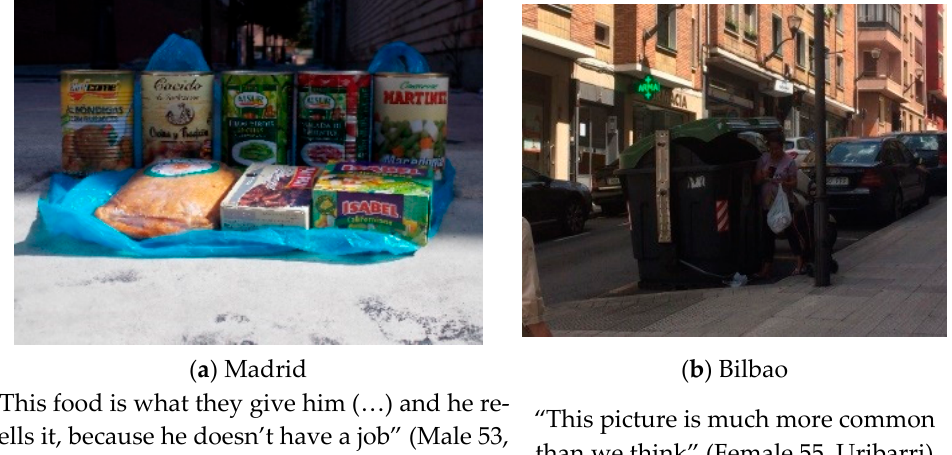
Figure 4. ( a ) Photographs made in Madrid: “Sale of street food”. Category: Illegal street vending. Theme: Economic crisis and food risk; ( b ) Photograph made in Bilbao: “Woman picking up trash”. Category: Insufficient feeding. Theme: Precariousness.